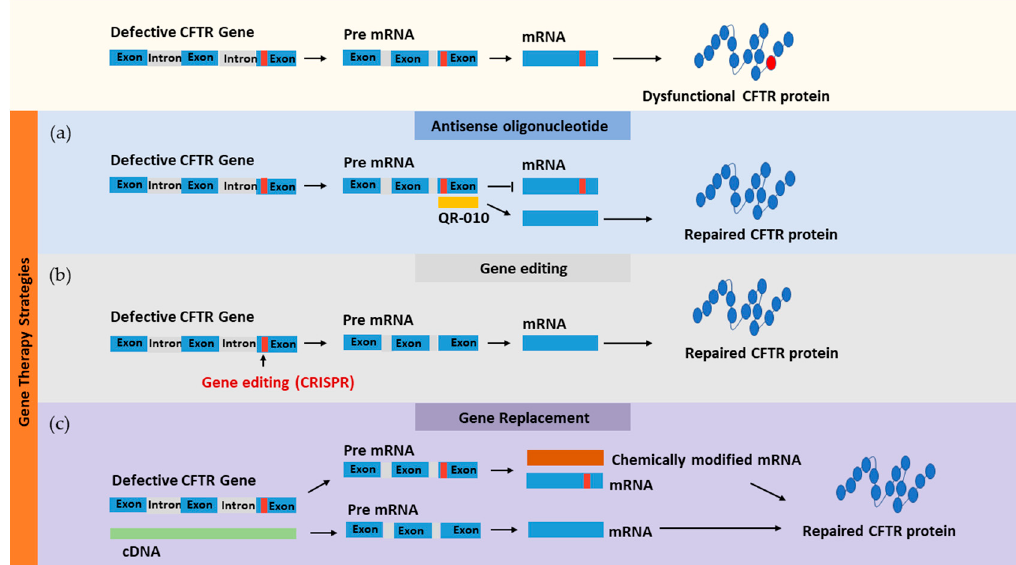
Figure 4. Gene-based therapeutic approaches for targeting faulty CFTR using different methods: ( a ) antisense oligonucleotide, ( b ) gene editing, and ( c ) gene replacement.